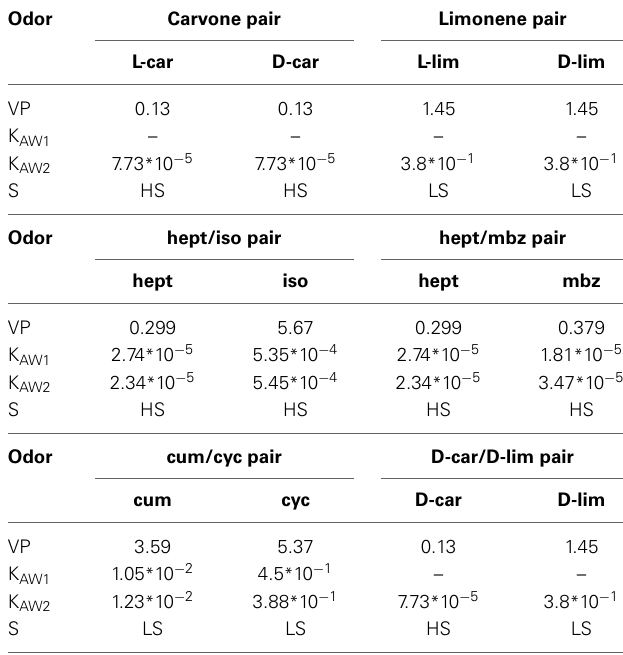
and S (sorptiveness).